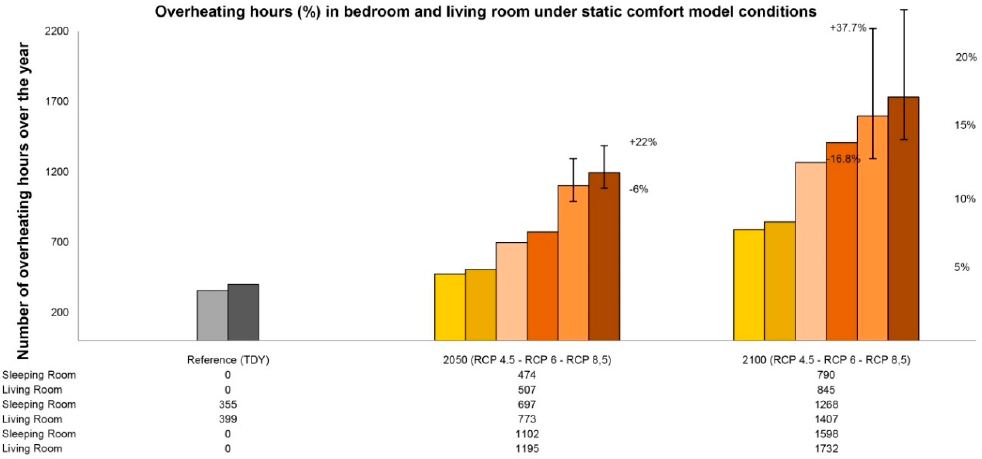
Figure 5. Results of climate and building thermal performance modeling under the Passive House comfort model.